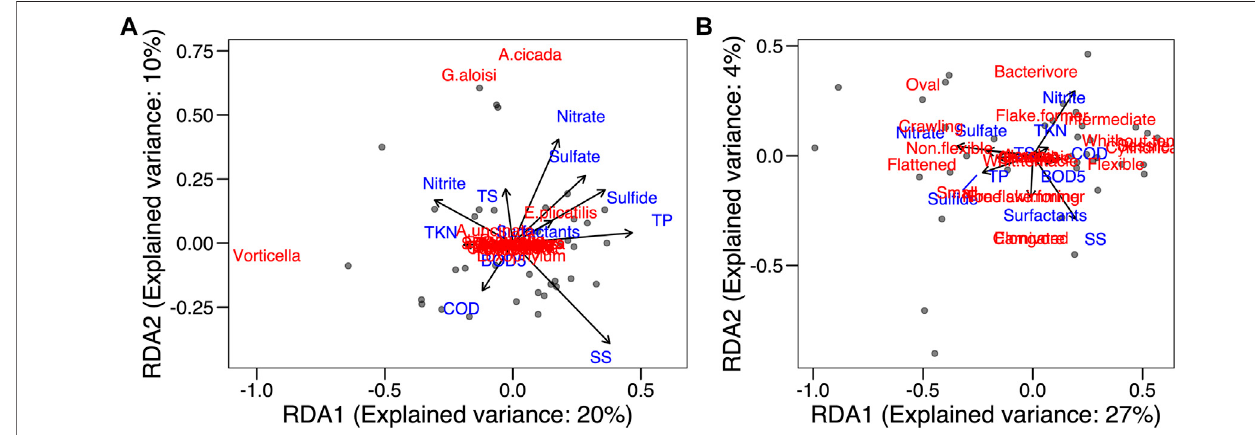
FIGURE 8 | Redundancy analysis. (A) species and environmental variables; (B) traits and environmental variables.